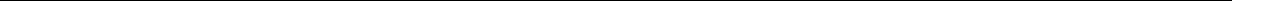
Fig. 1 Identi fi cation of temporally expressed lncRNAs across S-phase using nascent RNA capture assay. a Cell cycle diagram showing Nascent RNA capture at three different time points (2, 3.5, and 5 h) of S-phase. b Principle component analysis (PCA) of expression pro fi les by considering complete pro fi le (noncoding and protein-coding), all noncoding and only lncRNAs. c Time-series analysis of S-phase associated lncRNAs with twofold enrichment at least in one time point over the unsynchronized sample. The S-phase lncRNAs show four signi fi cant temporal patterns with STEM clustering. Venn diagram shows the overlap of lncRNAs enriched in EtU labeled and unlabeled samples. The p -values are obtained using permutation tests from STEM clustering. d Molecular pathway analysis (left) and gene ontology (right) enrichment analysis for nearby (<50 kb proximity) protein-coding genes to S-phase associated lncRNAs. The KEGG pathways or biological functions presented in the heatmaps show at least 10 genes with p -value < 0.05. The hypergeometric p -values are obtained from GeneSCF for pathway and GO enrichment analysis. e Work fl ow of the analysis for the identi fi cation of S-phase associated lncRNAs